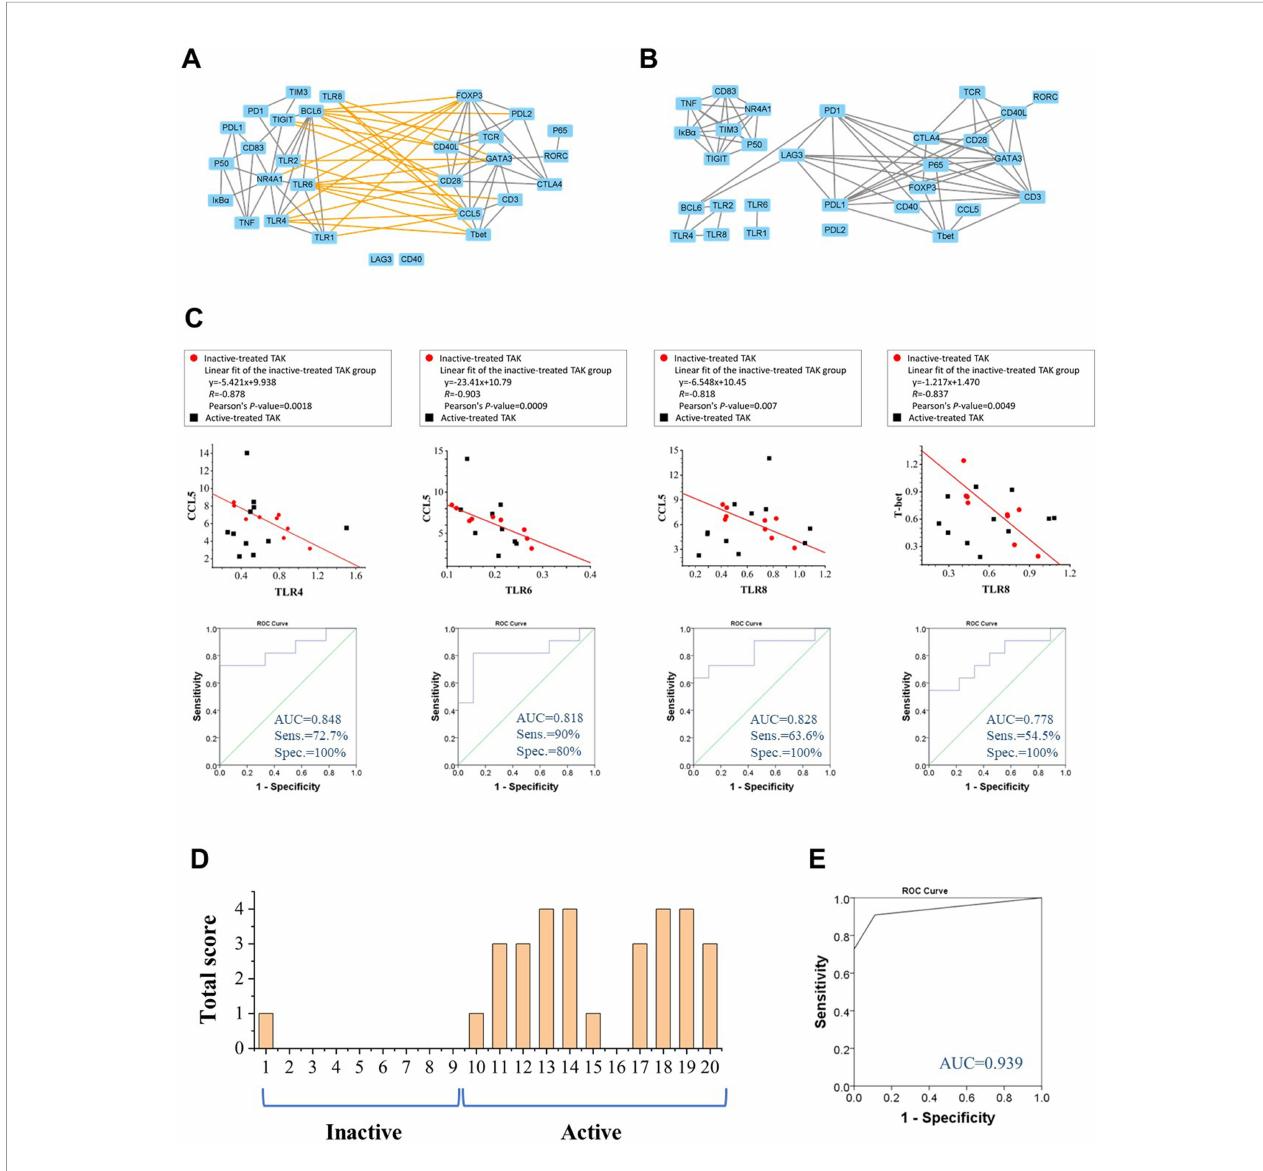
FIGURE 4 | Toll-like receptors (TLRs) and their correlation cluster distinguish active patients from inactive patients in TAK. (A, B) The Pearson correlation between the expression levels of each gene pair of the inactive-treated TAK group (A) and the active-treated TAK group (B) showed that the inactive-treated TAK group exhibited a unique pattern of inverse correlations between the TLRs gene cluster and the gene cluster associated with T-cell activation and differentiation, while the active-treated TAK group did not. (C) The scatter plots, the linear regression, and the receiver operating characteristic curve (ROC) of the TLR4-CCL5 pair, the TLR6-CCL5 pair, the TLR8-CCL5 pair, and the TLR8-Tbet pair. (D, E) The ROC analysis was used to evaluate the assessment accuracy for the disease activity of TAK. The total score of each treated-TAK patient (D) and the ROC (E) when assessing the disease activity using the summed scoring system consisting of the above 4 gene pairs. TAK, Takayasu ’ s